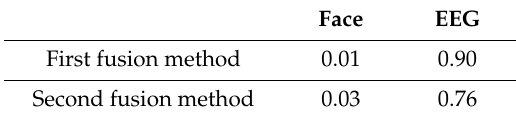
Table 8. The results of statistical tests in the online experiment in valence space.